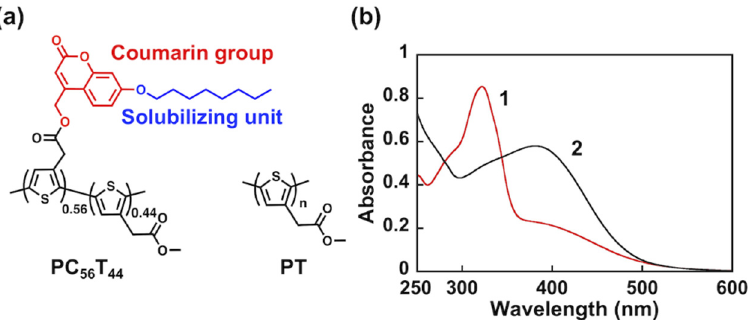
Figure 1. ( a ) Chemical structures of PC 56 T 44 and PT. ( b ) Absorption spectra of ( 1 ) PC 56 T 44 and ( 2 ) PT in THF. in